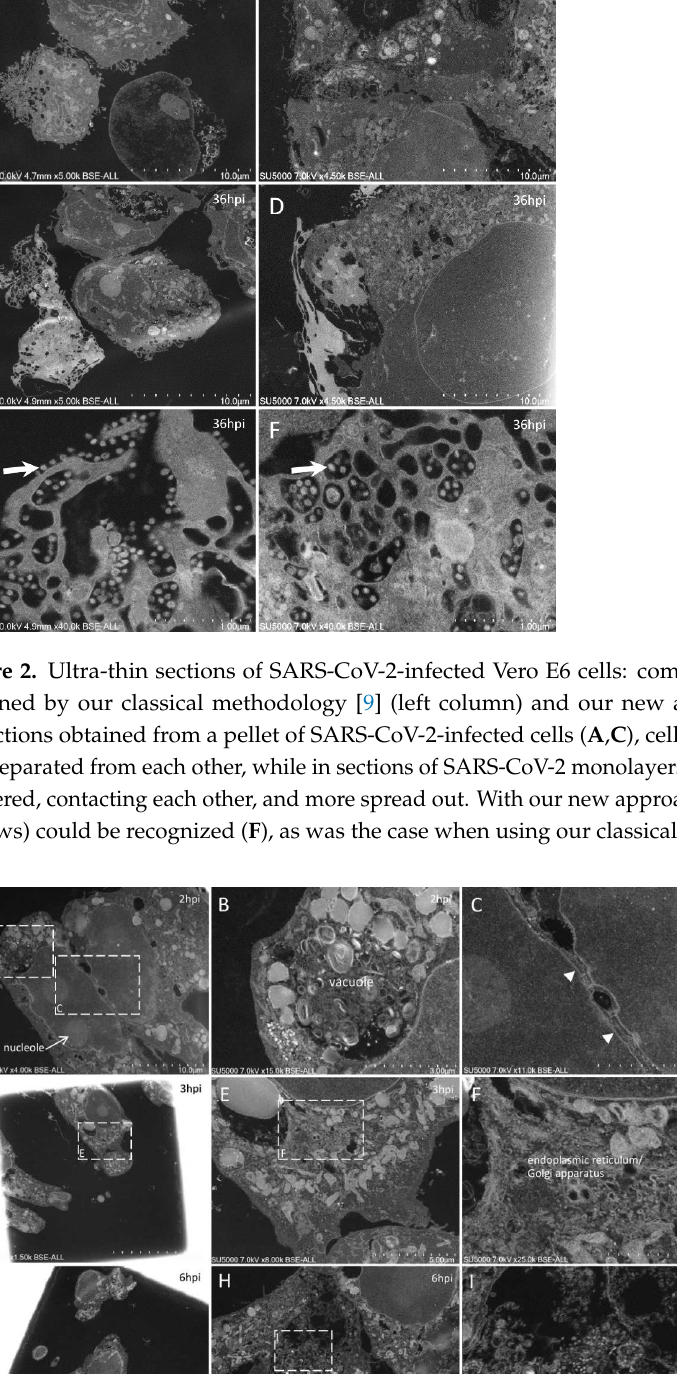
Figure 3. Ultra-thin sections of SARS-CoV-2-infected Vero E6 cells: 2–6 hpi. ( A – C ): 2 hpi. Two cells ( A ) with plasma membranes closely associated with a ‘Velcro’ organization ( C ; arrowheads). One of the two cells presents a large vacuole enriched in membranes and granules ( B ). ( D – I ): 3 hpi. One cell ( D ) presents the typical budding of the endoplasmic reticulum and/or Golgi apparatus compartments following SARS-CoV-2 infection ( E , F ). ( G – I ): 6 hpi. A region ( H ) located between intact cells and containing debris and mature SARS-CoV-2 particles ( I ;